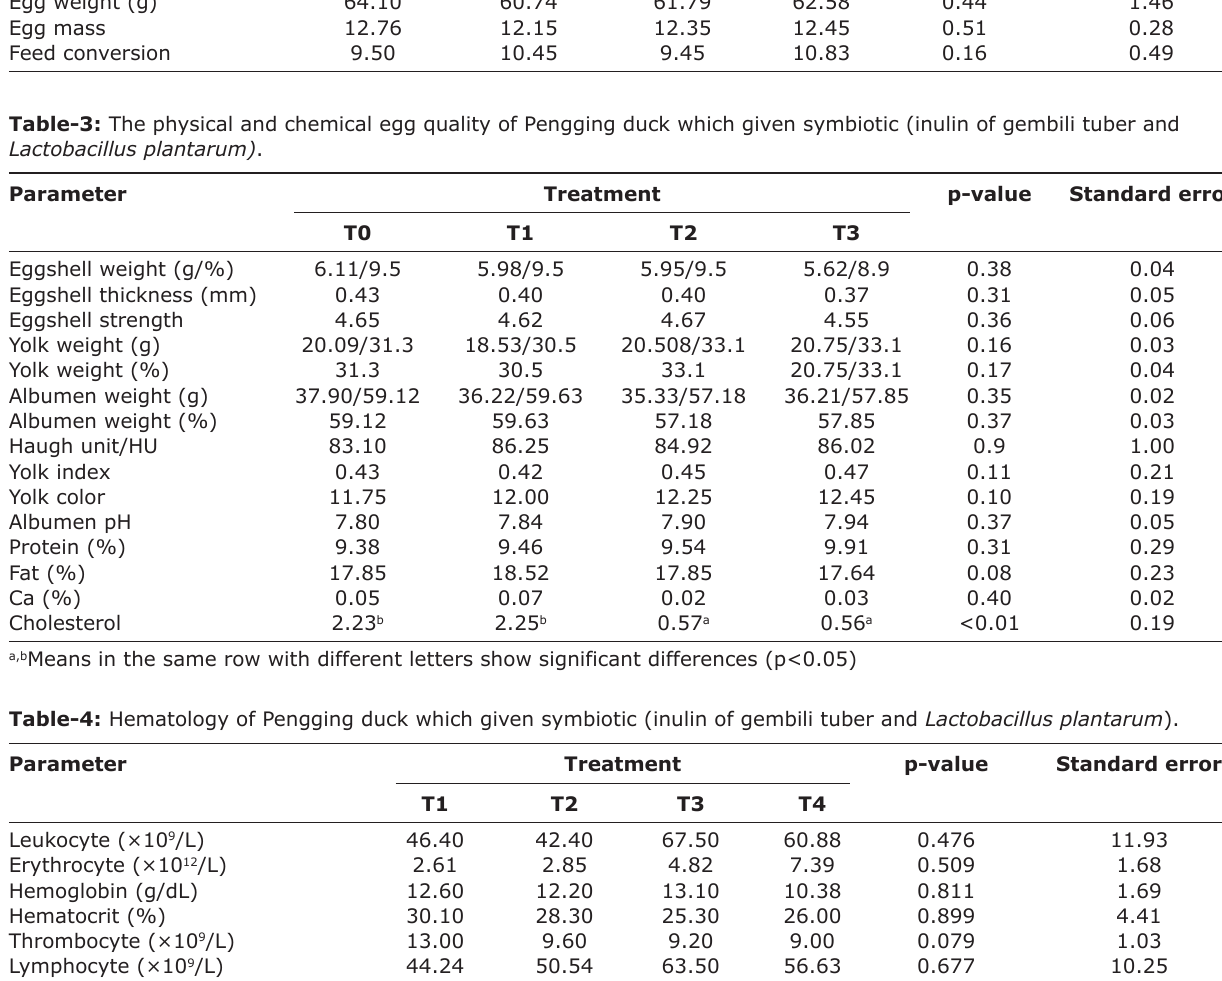
Egg production (%/day)